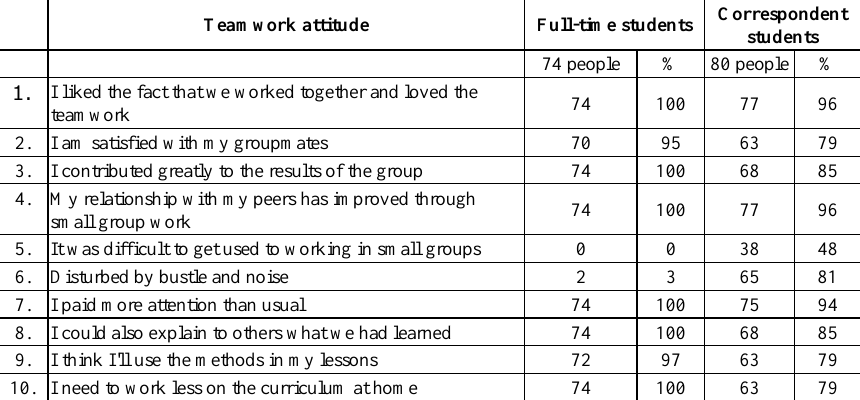
Table 2. Students' attitudes towards cooperative teamwork and elements of social